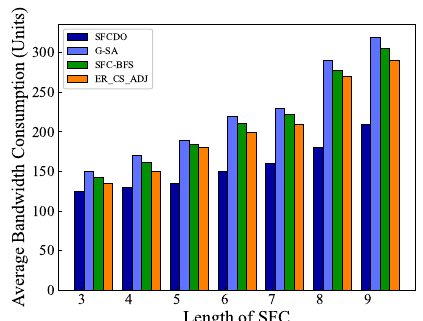
Figure 7. Average bandwidth consumption of SFCs in small